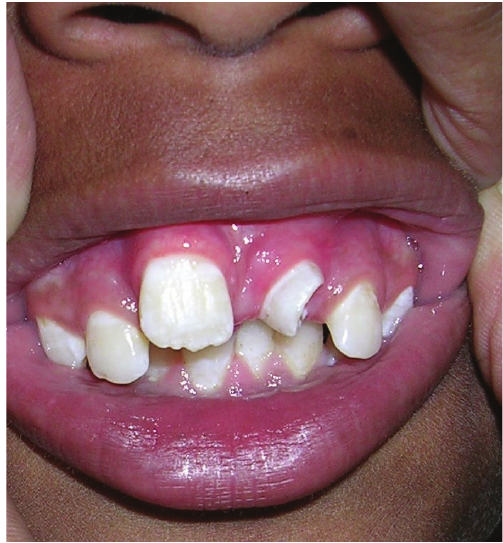
Figure 1: Clinical picture showing horizontal partial eruption on mesiodens.